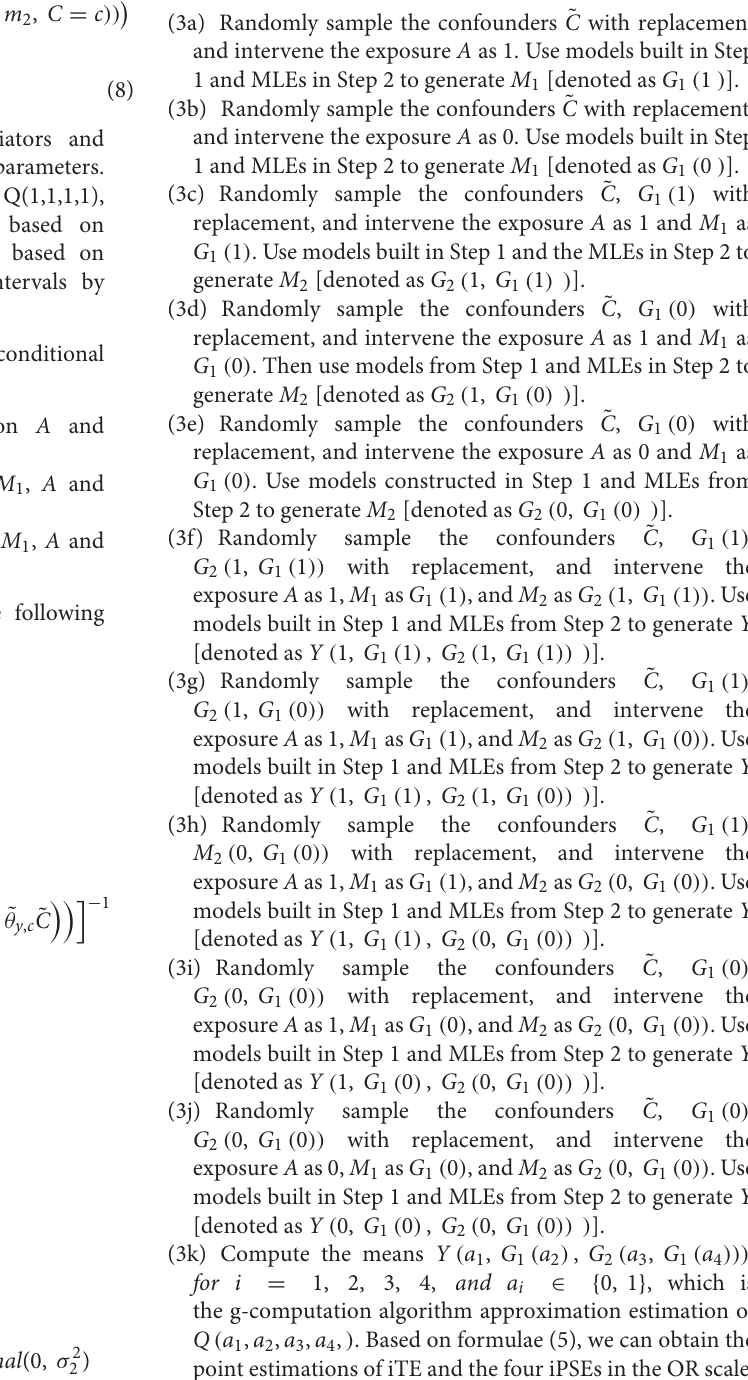
(step 3) Conduct g-computation algorithm using MLE and bootstrap.